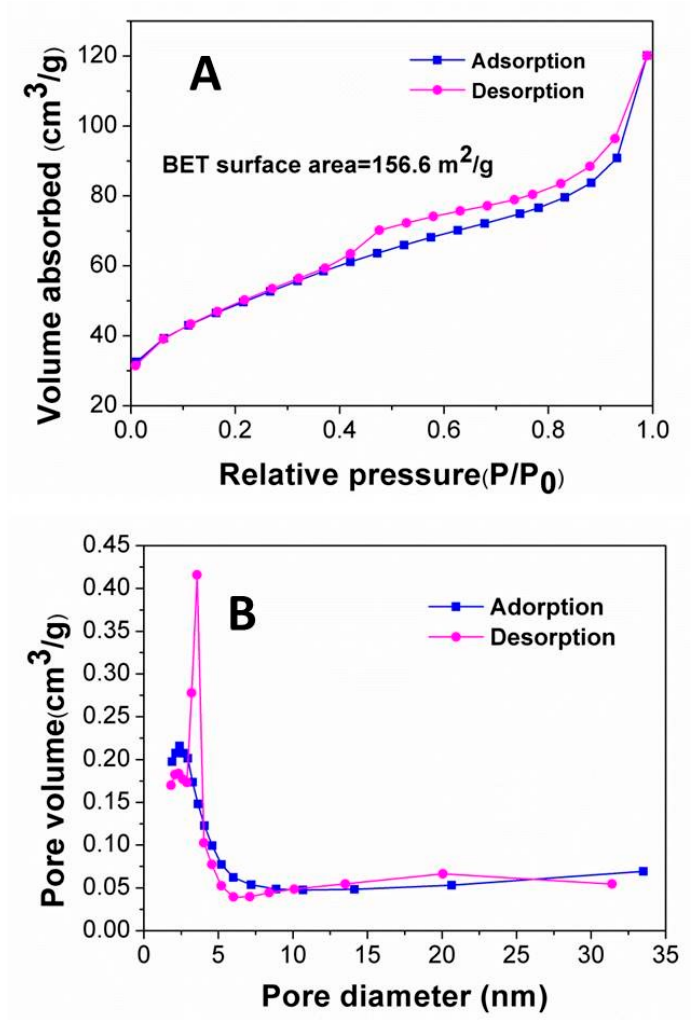
Figure 6. The nitrogen (N 2 ) adsorption-desorption isotherms ( A ) and pore size distribution ( B ) of 0.5% Au-1.75% Ag decorated TiO 2 composites.